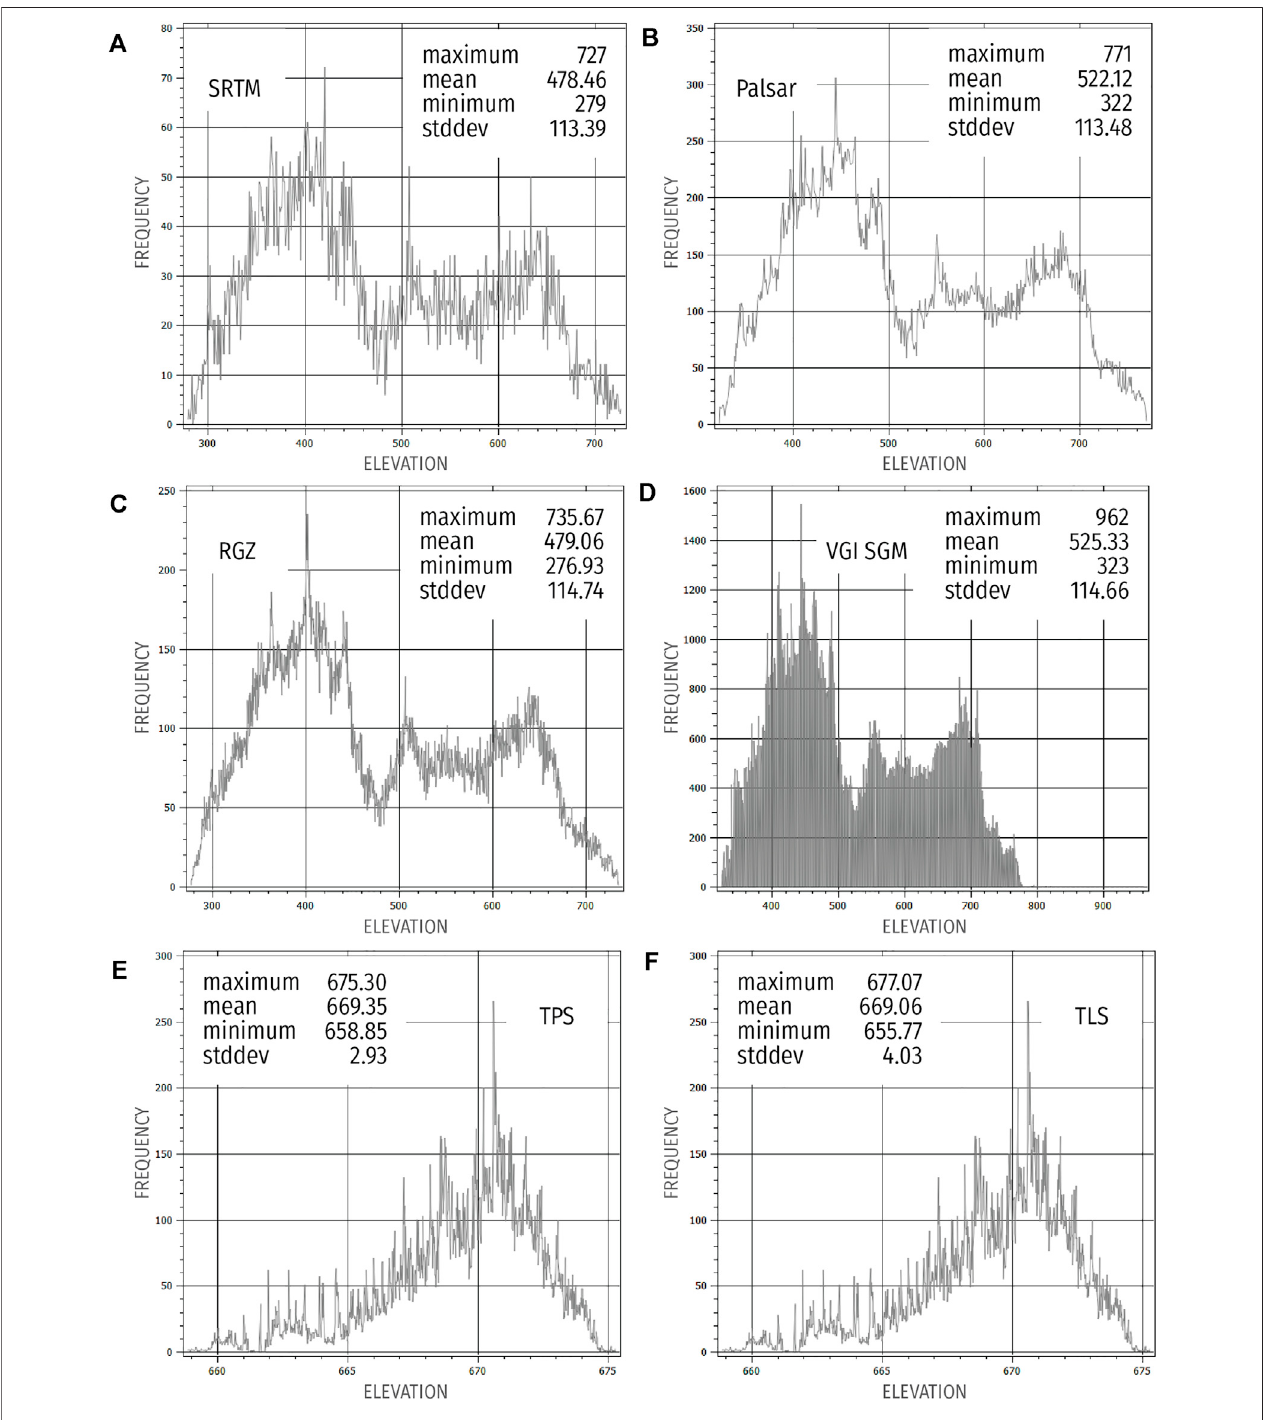
FIGURE 6 | Histogram of elevation frequency for analyzed DEMs: (A) SRTM; (B) PALSAR; (C) RGZ; (D) VGI SGM; (E) TPS; (F) TLS.